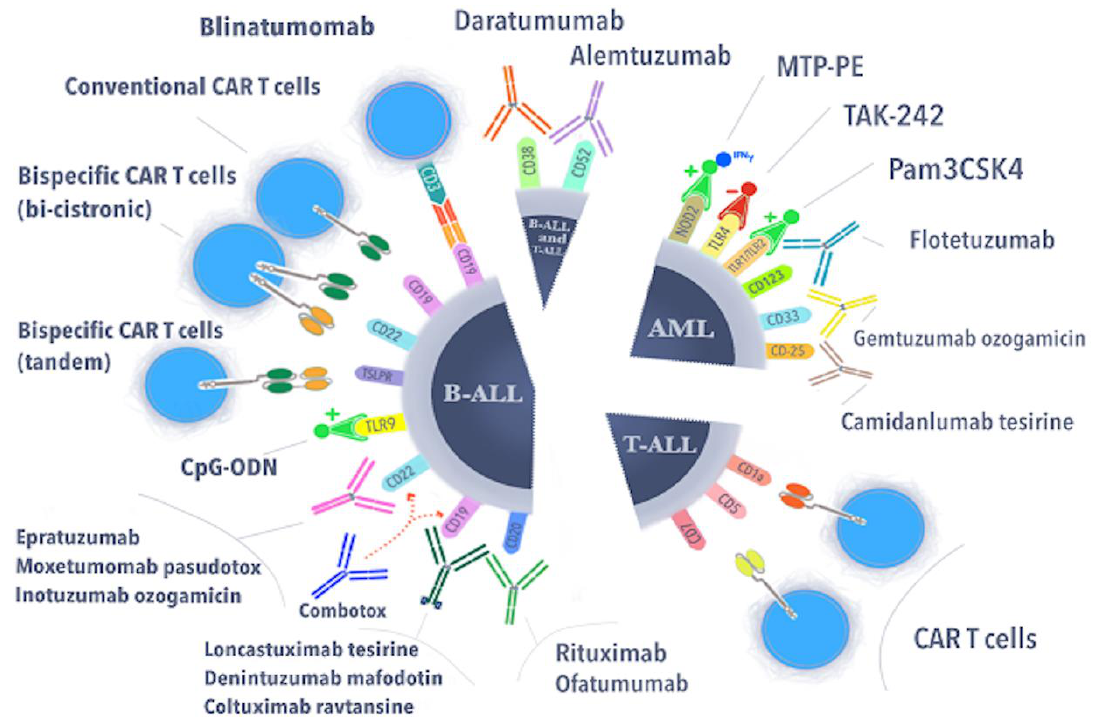
Figure 1. Current therapeutic approaches in the treatment of pediatric cases of acute leukemias.